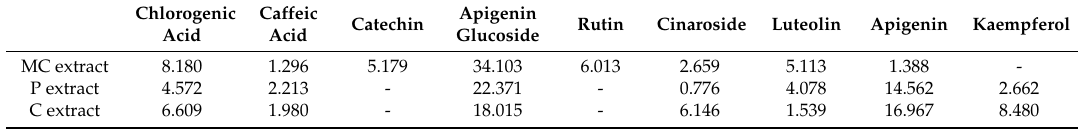
Table 1. The major polyphenolic compounds of the investigated plant samples by RP-UHPL ( µ g/100 µ g extract).